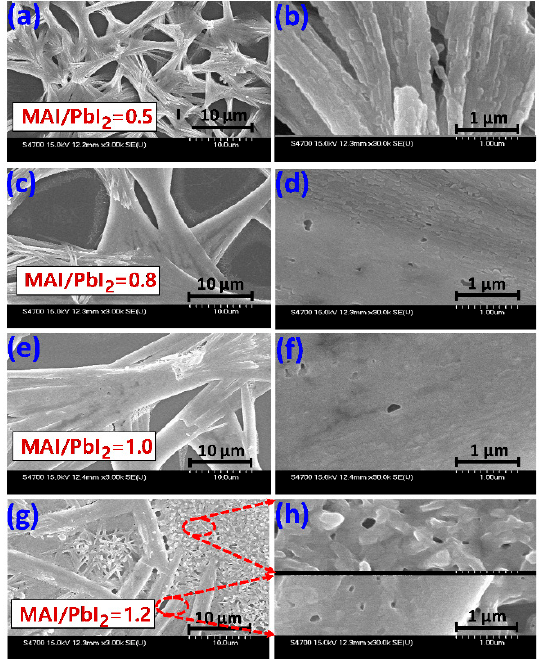
Figure 2. Scanning electron microscope (SEM) images of 10 µ m and 1 µ m magnification of MAPbI 3 films with varying MAI / PbI 2 ratios of ( a , b ) 0.5, ( c , d ) 0.8, ( e , f ) 1, and ( g , h ) 1.2.